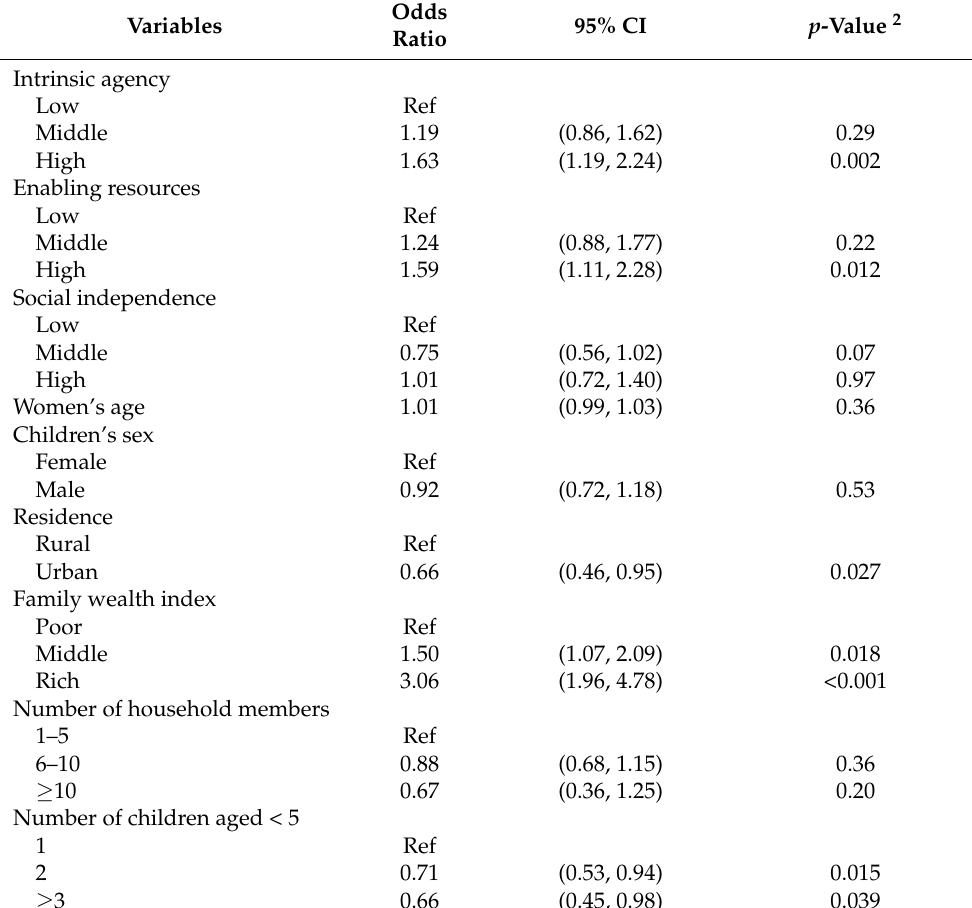
Table 3. Association between women’s empowerment and children’s complete vaccination in the DRC (N = 3524) 1